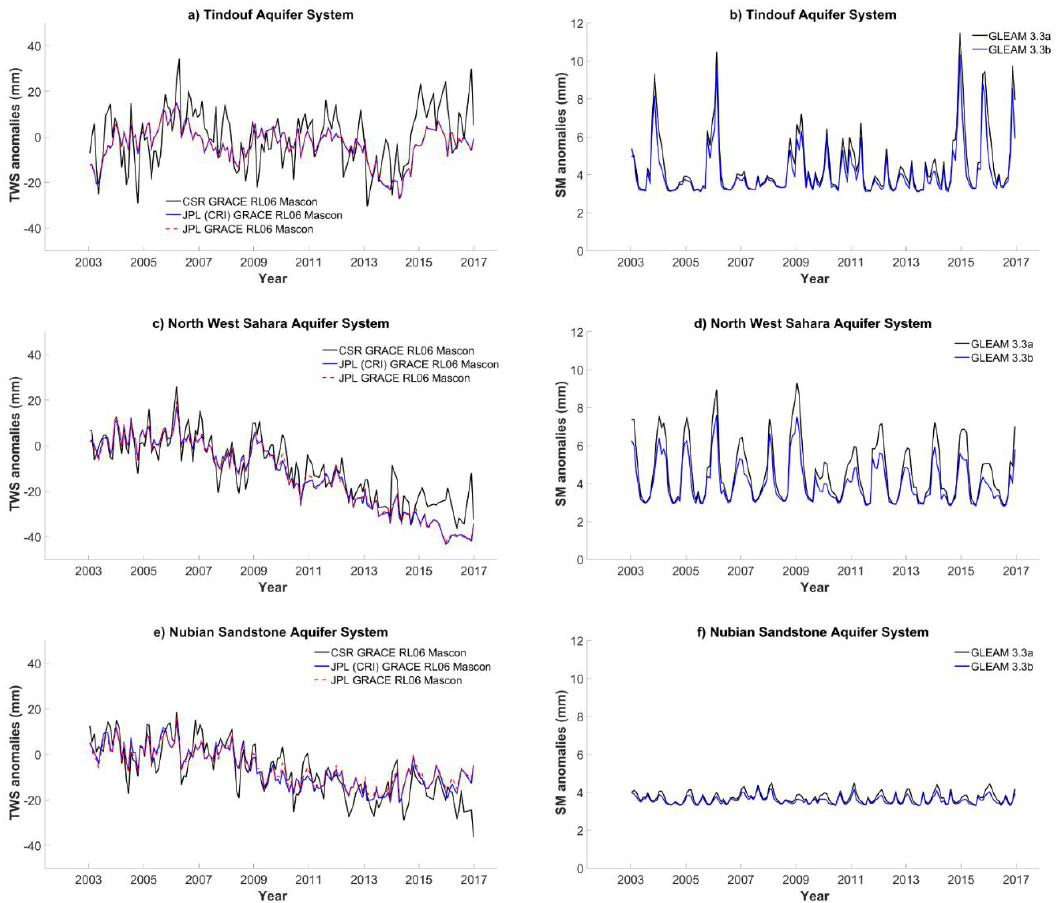
Figure 2. Time series of GRACE-based anomalies of TWS from the CSR RL06 (black), JPL (CRI) RL06 (blue), JPL (RL06) (dashed red) Mascon solutions (left panel) and SM anomalies from GLEAM 3.3a (black) and 3.3b (blue) (right panel) for TAS ( a , b ) NWSAS ( c , d ) and NSAS ( e , f ) respectively between 2003 and 2016.